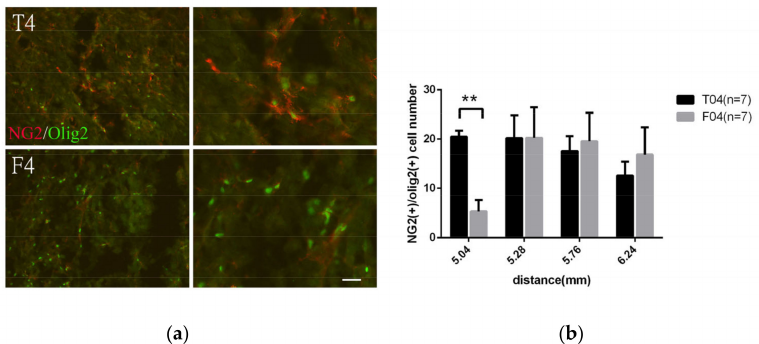
Figure 5. Cross-sections were collected in area ranging from 5 mm to 7 mm away from the trauma center. The sections were double stained withNG2 and OLIG2 to verify whether they were OPC cells ( a ). ( b ) The double-stained cells were counted in the injury site and compared between the T4 and F4 models. Pairwise t -test. **: p < 0.01. Data are presented as mean ± SEM. Scale bar = 50 µ m.